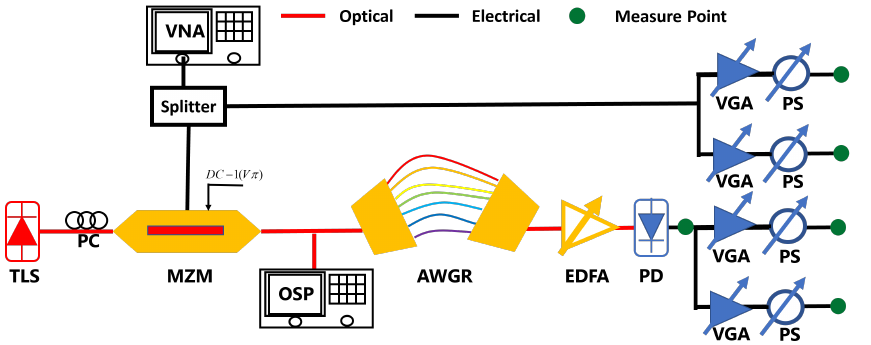
Figure 5. Schematic diagram of the measurement setup. TLS: tunable laser source; MZM: Mach–Zehnder modulator; PC: polarization controller; OSP: optical spectroscope; VNA: vector network analyzer; EDFA: erbium-doped fiber amplifier; AWGR: arrayed waveguide gratings router; PD: photodiode; VGA: variable gain amplifier; PS: phase shifter.